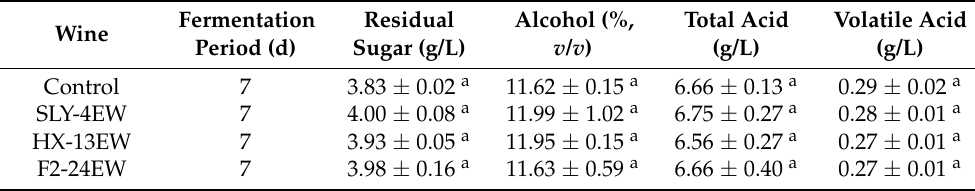
Table 1. Physiochemical characteristics of wines.